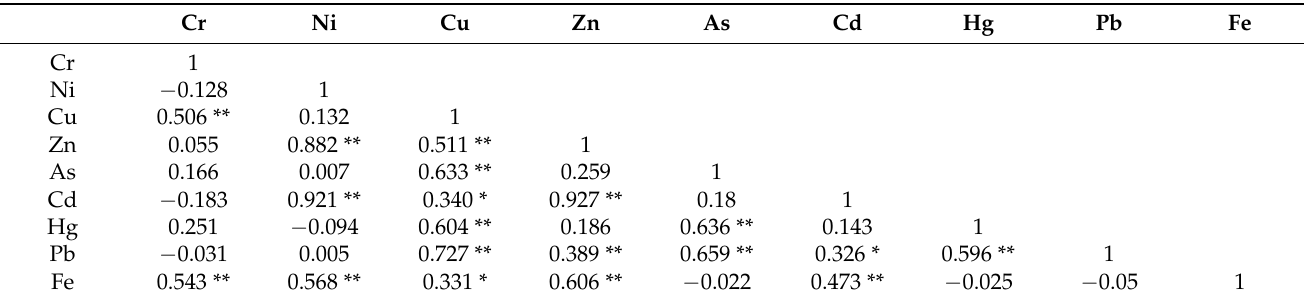
* Correlation is significant at the 0.05 level; ** Correlation is significant at the 0.01 level. In this study, the sphericity (0.6) was larger than 0.5, and the KMO result was less than 0.001, which indicated that the data was suitable for FA [68]. Based on eigenvalues (eigenvalue > 1), three main factors explained 87.918% of the total variance. The variance contribution rate of Factor 1 (F1) was 43.106%, and was positively correlated with Ni, Cd, Zn, and Fe (0.975, 0.964, 0.934, and 0.589), respectively (Table 3). The interrelationships between Ni, Zn, and Cd suggest the influence of local human activities (domestic waste and fertilization) and lithology (weathering of parent rocks) on soil samples [41]. F2, which explained 27.906% of the total variance, was highly positively correlated with Pb, As, Hg, and Cu (0.885, 0.856, 0.831, and 0.8), respectively. Many researchers [69,70] believe that the main reason for the enrichment of Cu and As in soils is the application of chemical fertilizers and pesticides. The high correlation between Hg and Pb was attributed to the automobile emissions from coal transportation and the fly ash produced by coal combustion [71]). F3 presented a variance contribution rate of 16.906%, and Cr and Fe presented high loads (0.954 and 0.734, respectively). The high ratio of residual fraction in Cr and Fe indicated